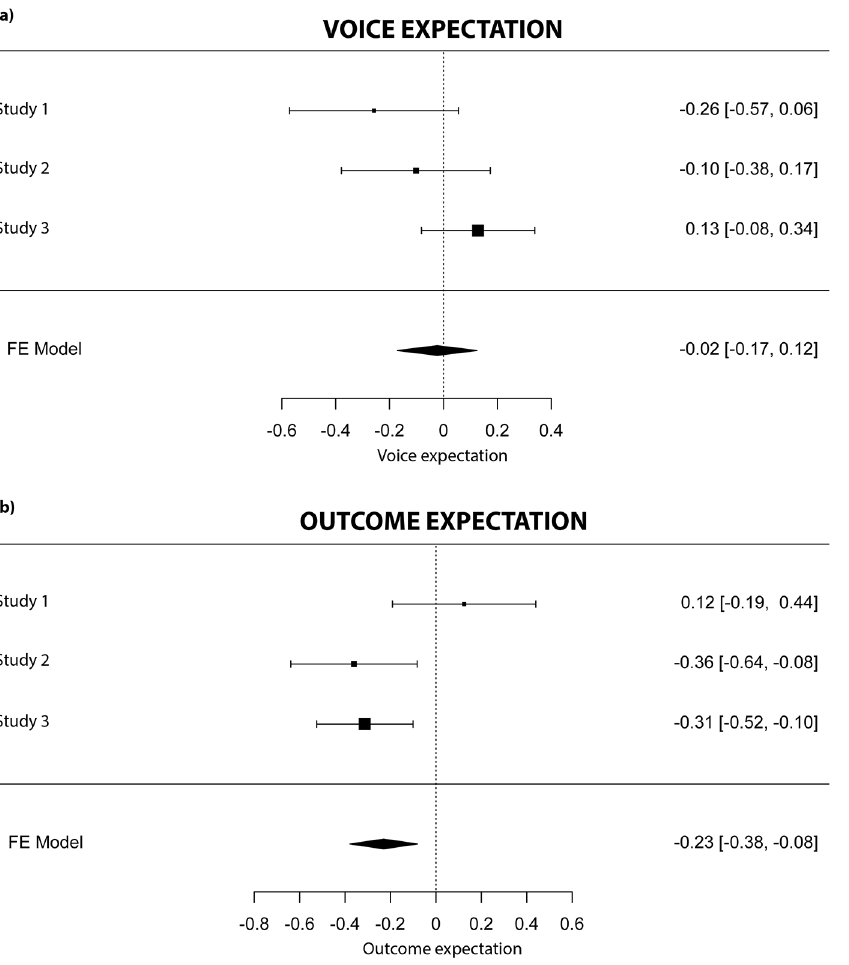
Figure 1. Forest plot of standardised mean difference in (a) voice expectation and (b) outcome expectation as a function of outgroup status in a fixed-effects meta-analytic